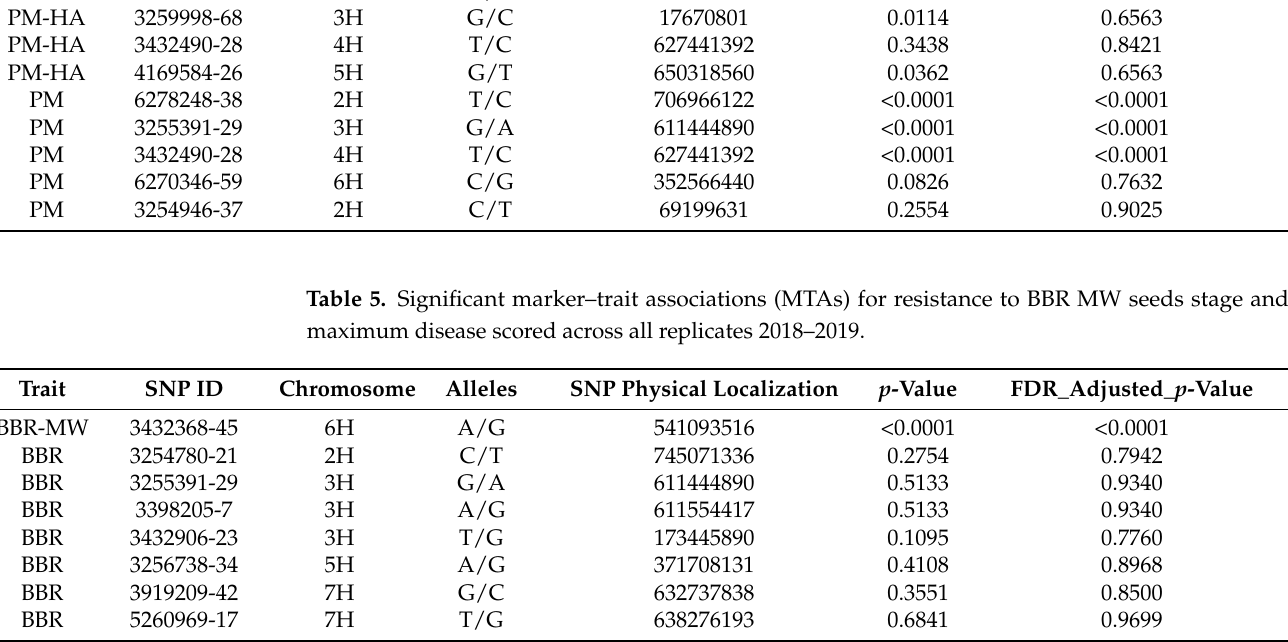
Figure 12. Single-nucleotide polymorphism (SNP) significantly associated with powdery mildew (PM) resistance in barley identified by genome-wide association study (GWAS) with BLINK model.